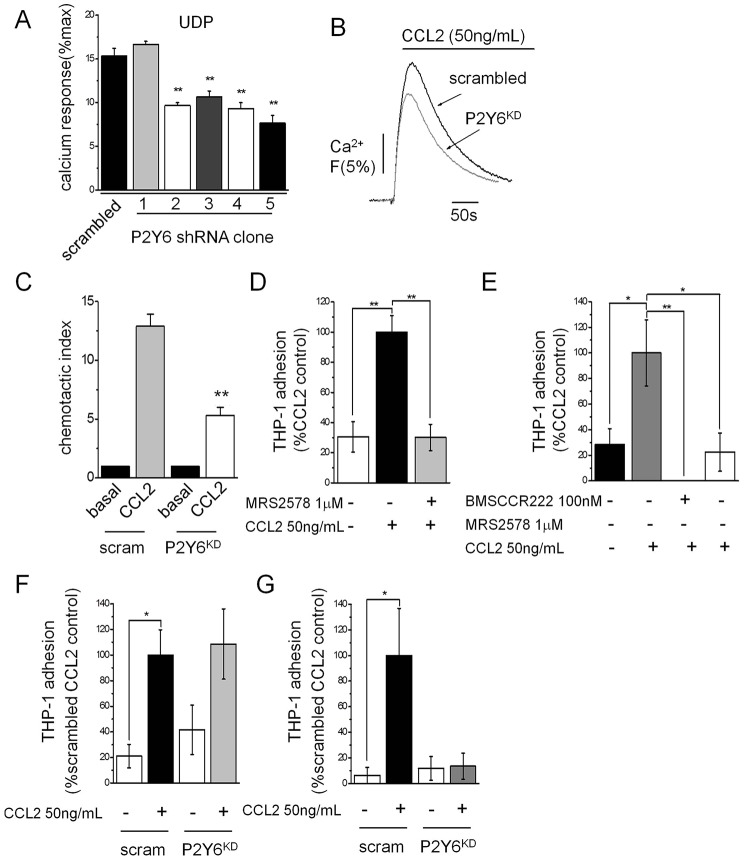
P2Y6-knockdown THP-1 cells have impaired CCL2-evoked Ca2+ signalling, chemotaxis and adhesion to TNFα-treated HUVECs. (A) Comparison of UDP (30 µM)-evoked Ca2+ responses in THP-1 stable lines expressing scrambled shRNA or P2Y6-targeted shRNA derived from 5 different clones (clone 1–5) (n = 3). Functional knockdown of UDP responses are revealed in clones 2–5. (B) Representative traces showing the attenuated Ca2+ response to CCL2 in P2Y6-knockdown (P2Y6KD) cells. (C) Impaired chemotactic response to CCL2 (50 ng/ml lower chamber, 2 h) observed in transwell migration assays for P2Y6KD cells versus scrambled THP-1 cells (n = 4). (D) CCL2 priming (50 ng/ml, 45 min) of THP-1 cells stimulated adhesion to non-inflamed HUVECs. P2Y6 inhibition (MRS2578, 1 mM) abolished CCL2-evoked adhesion (n = 20). (E) In inflamed HUVECs (TNFα, 10 ng/ml, 5 h), CCL2 priming (50 ng/ml, 45 min) of THP-1 cells also stimulated adhesion that could be blocked by pre-treatment with either BMSCCR222 (100 nM) or MRS2578 (1 µM) (E) (n = 8 for both). (F) P2Y6 knockdown causes variable adhesion of CCL2-primed THP-1 cells to TNFα-treated HUVECs as compared for scrambled (scram) and P2Y6-knockdown lines (n = 6). (G) CCL2-primed P2Y6-knockdown THP-1 cells display impaired adhesion to inflamed HUVECs (TNFα, 10 ng/ml, 5 h) versus scrambled counterparts (n = 8). P2Y6KD refers to clone 5 (as shown in A) throughout. Fluo-4 signals are normalised to the maximum Ca2+ response elicited by 40 µM digitonin. **P<0.01, *P<0.05 (ANOVA). Data are presented as mean±s.e.m. All antagonists were pre-incubated for 30 min prior to agonist challenge.